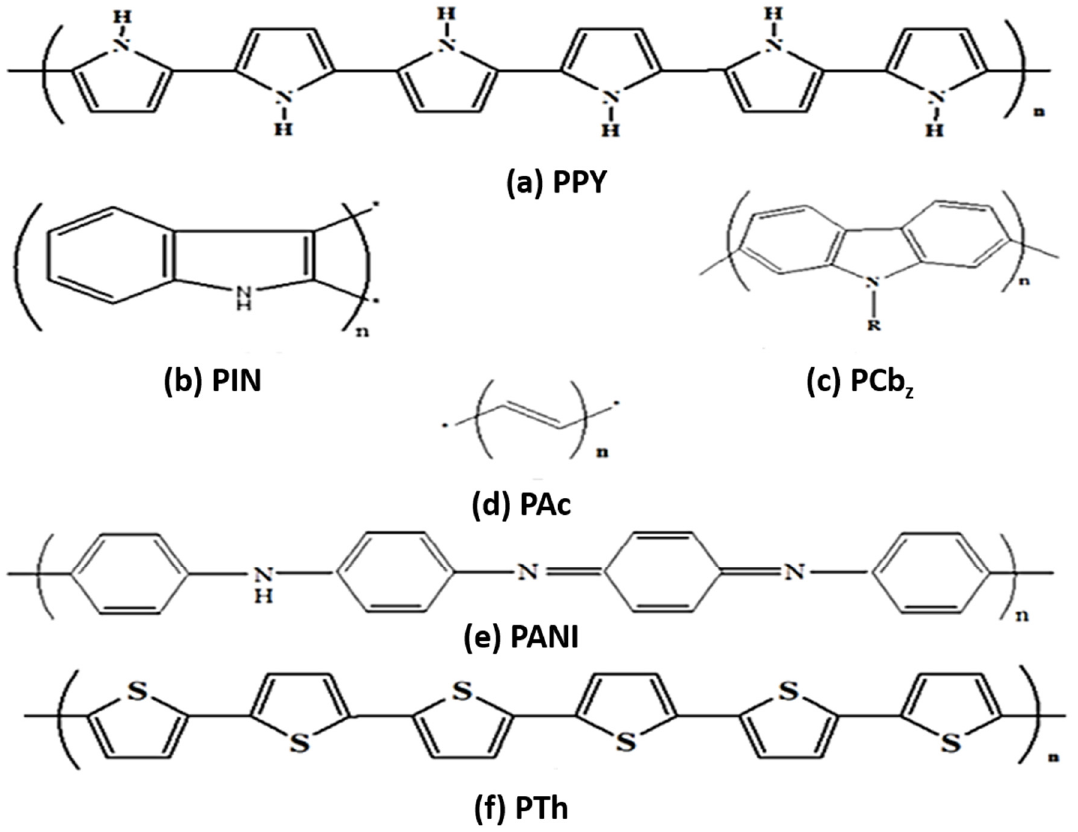
Figure 2. ( a ). PPY; ( b ). PIN; ( c ). PCbz; ( d ). Pac; ( e ). PANI; and ( f ). PTh-based CPs are used for semiconducting and electrochemical applications. Reproduced with permission from [9–16].